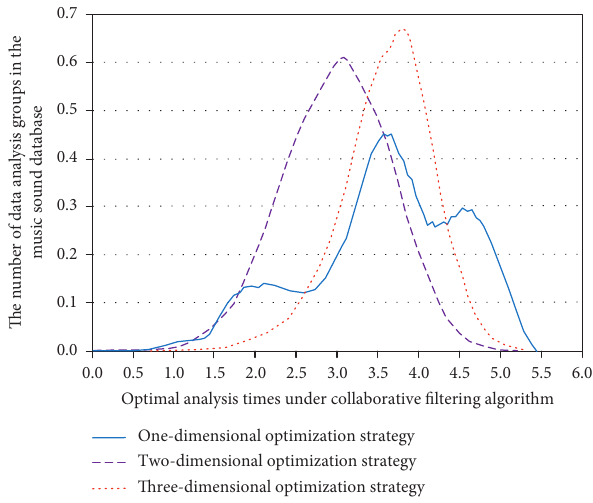
Figure 4: Number of data analysis groups of the music sound database under different dimensional optimization